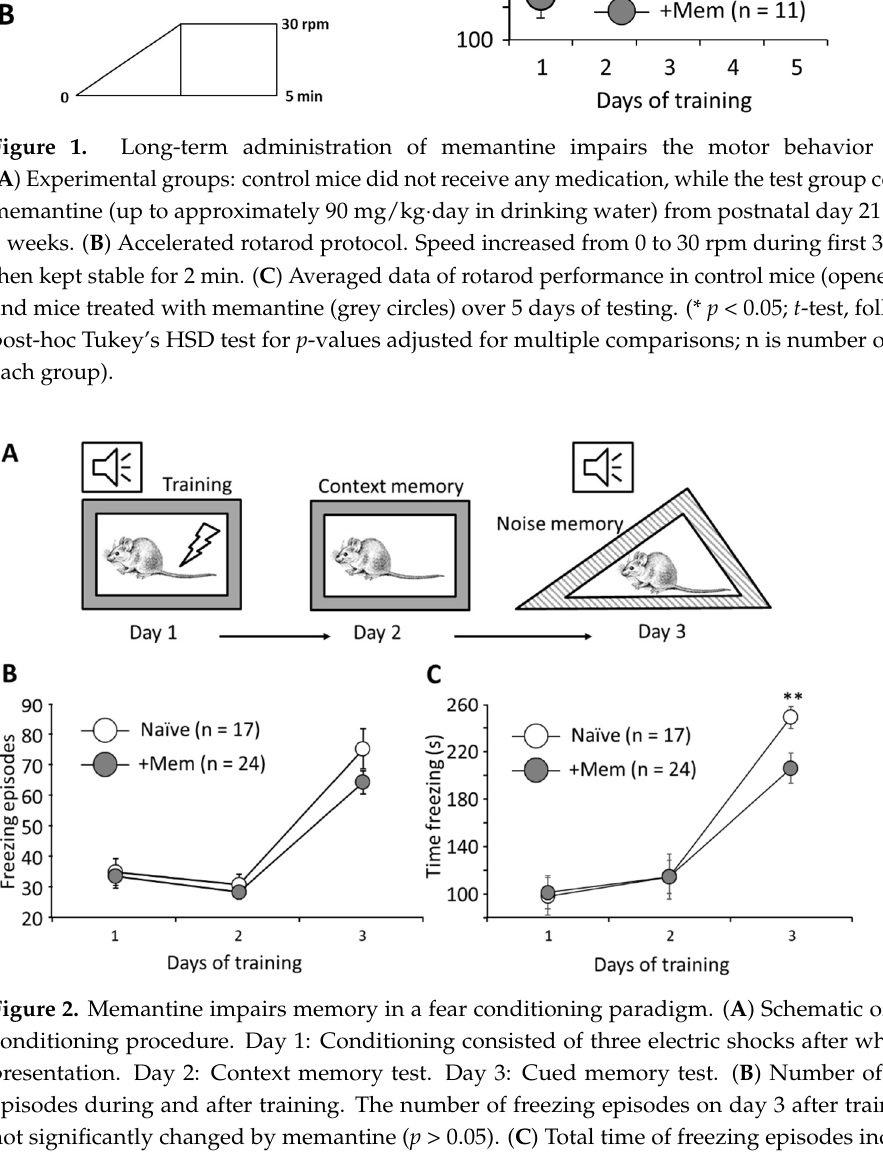
Figure 1. Long-term administration of memantine impairs the motor behavior in mice. ( A ) Experi- mental groups: control mice did not receive any medication, while the test group consumed me- mantine (up to approximately 90 mg/kg ∙ day in drinking water) from postnatal day 21 (p21) for 9 weeks. ( B ) Accelerated rotarod protocol. Speed increased from 0 to 30 rpm during first 3 min and then kept stable for 2 min. ( C ) Averaged data of rotarod performance in control mice (opened cir- cles) and mice treated with memantine (grey circles) over 5 days of testing. (* p < 0.05; t -test, followed by post-hoc Tukey’s HSD test for p -values adjusted for multiple comparisons; n is number of mice in each group).